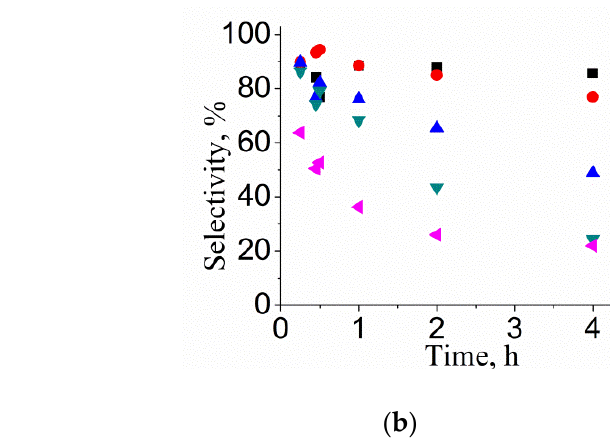
Figure 5. The temperature influence on the FAME conversion ( a ) and epoxide selectivity ( b ). Reaction conditions: FAME content of 1 wt%; catalyst content of 15 g · L − 1 ; unsaturated FAME:H 2 O 2 molar ratio of 1:8; and temperature of 30 °C ( ), 40 °C ( ), 50 °C ( ), 60 °C ( ) and 70 °C ( ).